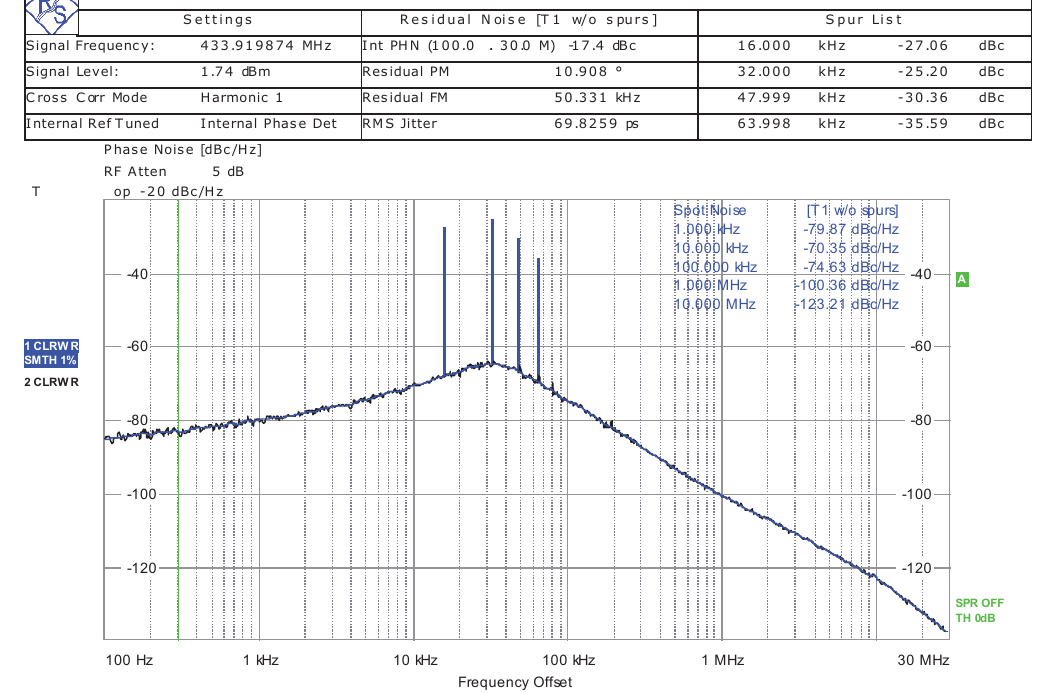
Figure 12. The measured phase noise of the